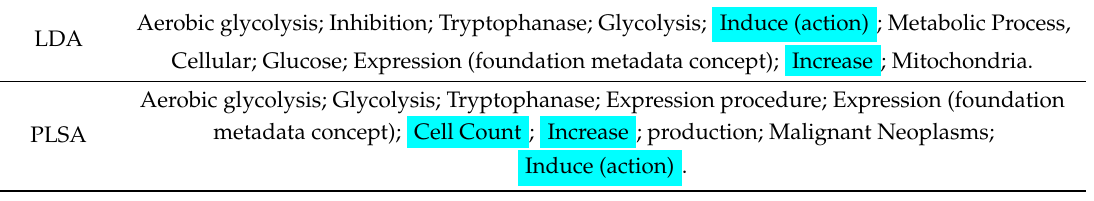
Table 17. The top-1 topic on the avoiding immune destruction (AID) hallmark.